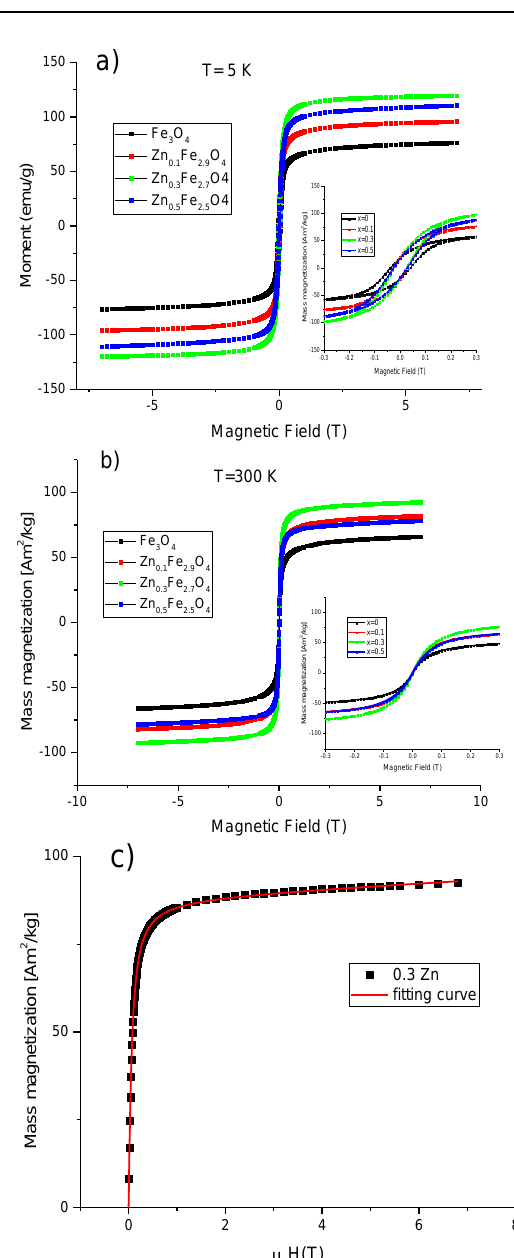
Figure 6. Magnetization curves for Zn x Fe 3 − x O 4 MNPs (0 ≤ x < 0.5) at ( a ) 5 K and ( b ) 300 K. Insets represents low-field regime hysteresis loops. ( c ) Magnetization curve fitting for the Zn 0.3 Fe 2.7 O 4 MNPs at 300 K; the blue squares represent the experimental data and the orange line is the fitting curve.